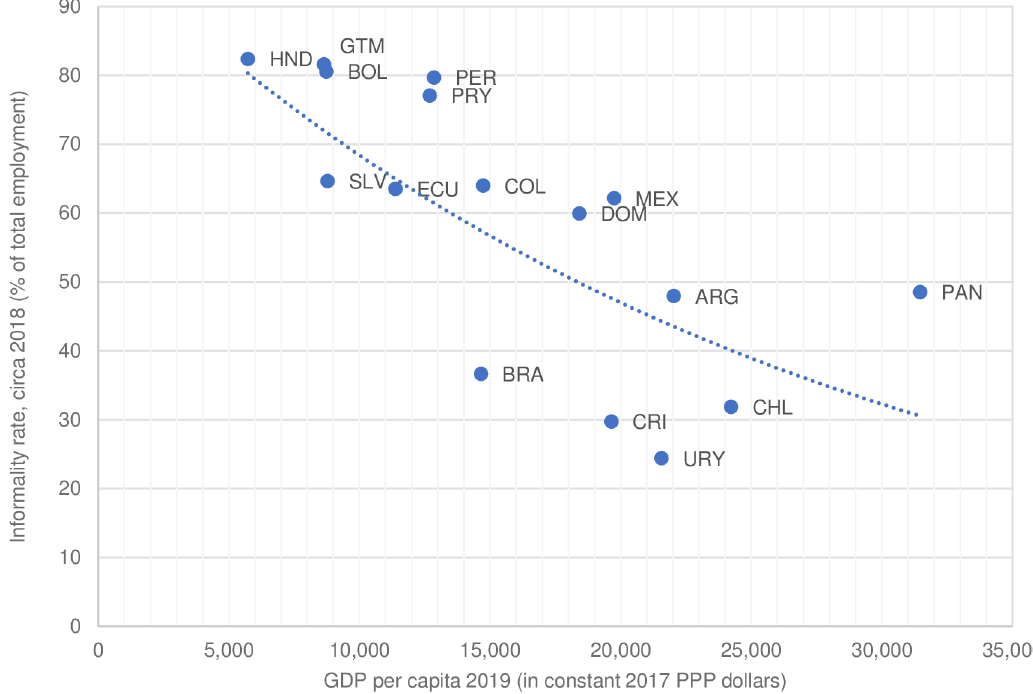
Fig 2. Informality rate of the population age 15 and older and GDP per capita in Latin America. Sources: Based on household survey data and on data from the World Bank’s World Development Indicators. PPP: purchasing power parity. ARG: Argentina, BOL: Bolivia, BRA: Brazil, CHL: Chile, COL: Colombia, CRI: Costa Rica, ECU: Ecuador, SLV: El Salvador, GTM: Guatemala, HND: Honduras, MEX: Mexico, PAN: Panama, PRY: Paraguay, PER: Peru, DOM: Dominican Republic, URY: Uruguay.